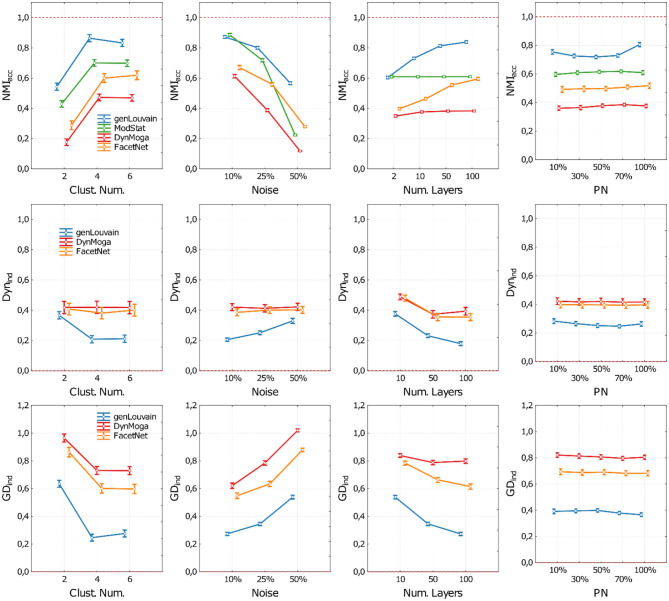
Plot of means and standard deviations of the three indices used to execute the comparative analysis on networks with evolving community structure. Each row of the figure corresponds to one index (NMIacc, Dynind, and GDind). For each index, we report four panels where we show the algorithms' performances with respect to the cluster number (first column), noise level (second column), number of network's layer (third column), and percentage of nodes changing module (fourth column). Algorithms are identified through a color code (blue—genLouvain, green—ModStat, red—DynMoga, orange—FacetNet). In each panel, we can see how the performance of the algorithms varies according to the values of the ANOVA factors and which algorithm reaches highest performances in terms of accuracy (NMIacc), stability (Dynind), or both (GDind). The optimal performances are indicated though a red dotted line.